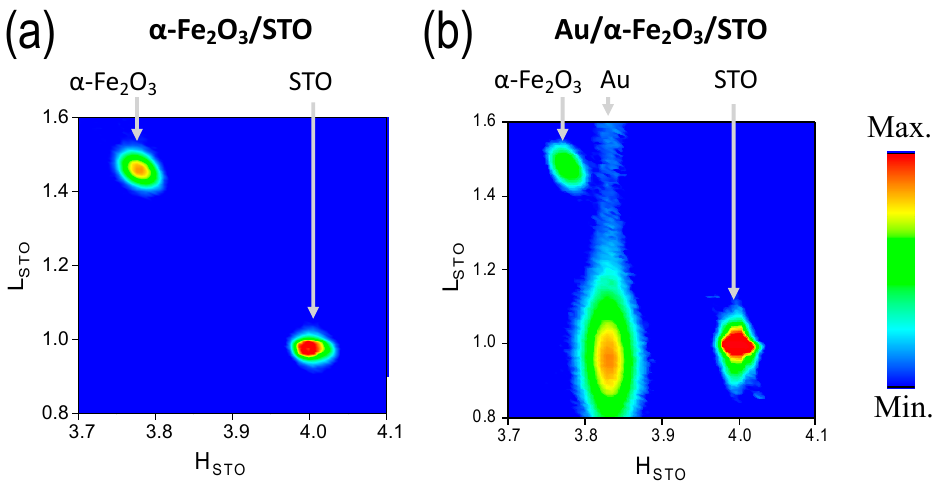
Figure 5. LH reciprocal space maps (RSM) for ( a ) α -Fe 2 O 3 layer grown on STO(111) substrate and ( b ) Au/ α -Fe 2 O 3 bilayer prepared on STO(111) substrates. An incommensurate epitaxial growth is identified from a non-coincidence of Au(111), α -Fe 2 O 3 (0001), and STO(111) substrate in-plane peaks (marked in each figure). The color scale corresponds to the signal intensity.